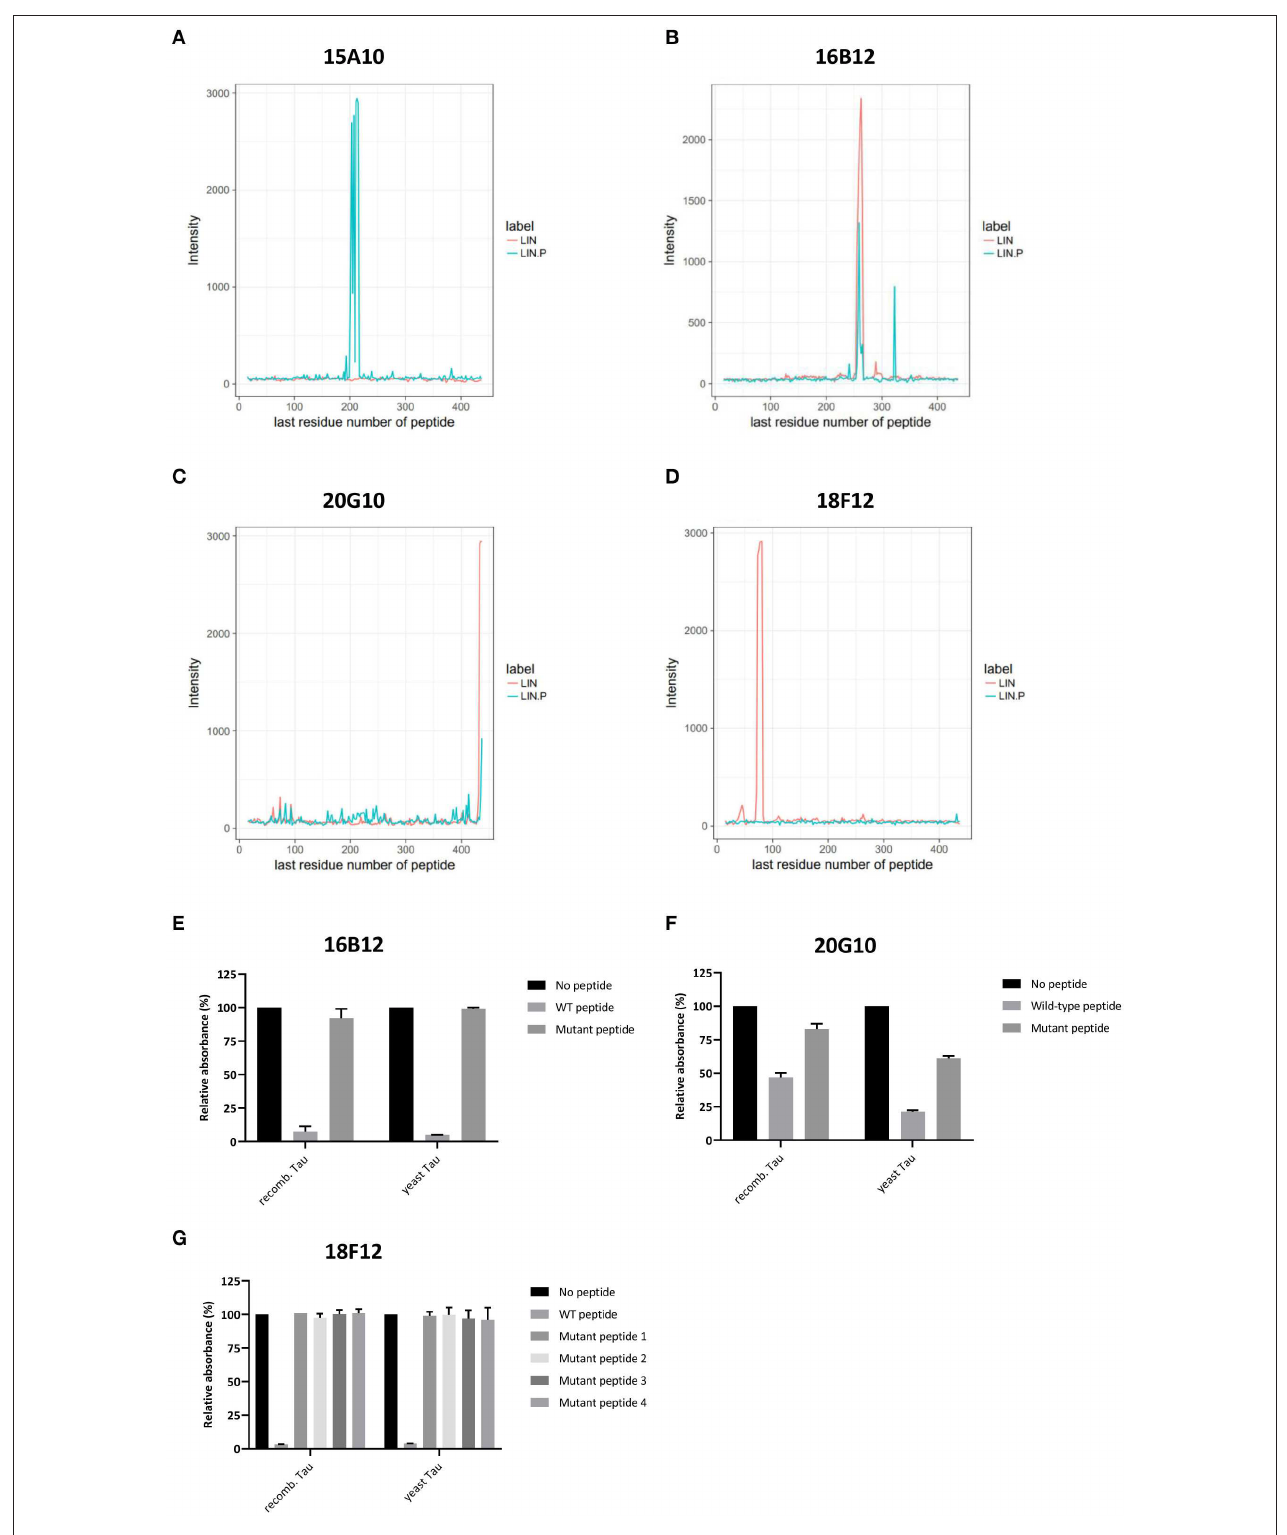
FIGURE 3 | Delineation of epitopes using an ELISA-based peptide array scanning method performed by Pepscan. (A–D) Linear intensity profile recorded for (A) 15A10, (B) 16B12, (C) 20G10, and (D) 18F12. The overlay of intensity profiles recorded on the non-phosphorylated peptide set (red) and the phosphorylated